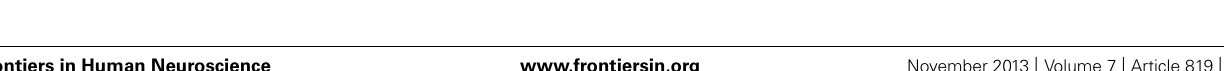
Frontiers in Human